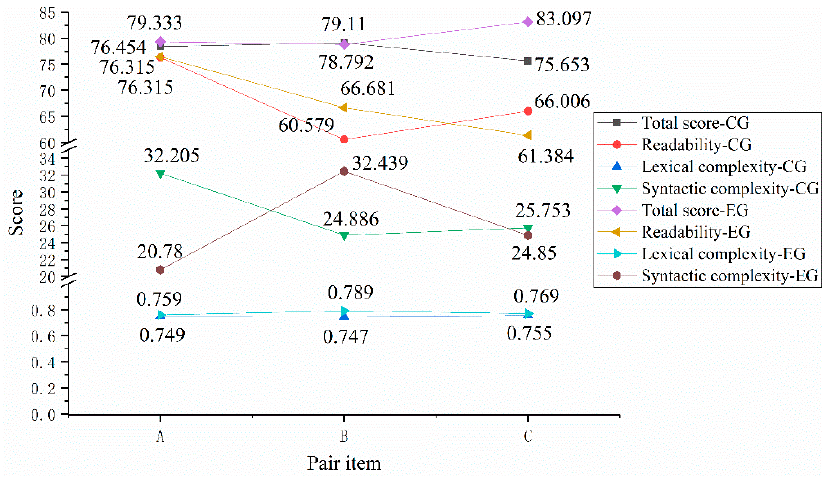
Figure 4. Descriptive statistics in pretest.